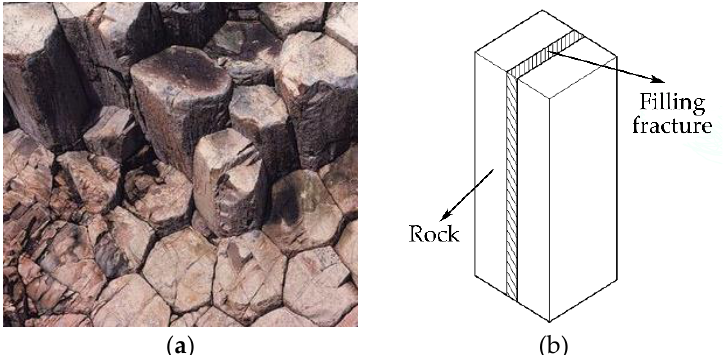
Figure 1. Typical fractured rock mass: ( a ) columnar jointed rock mass; ( b ) schematic diagram of fractured rock.